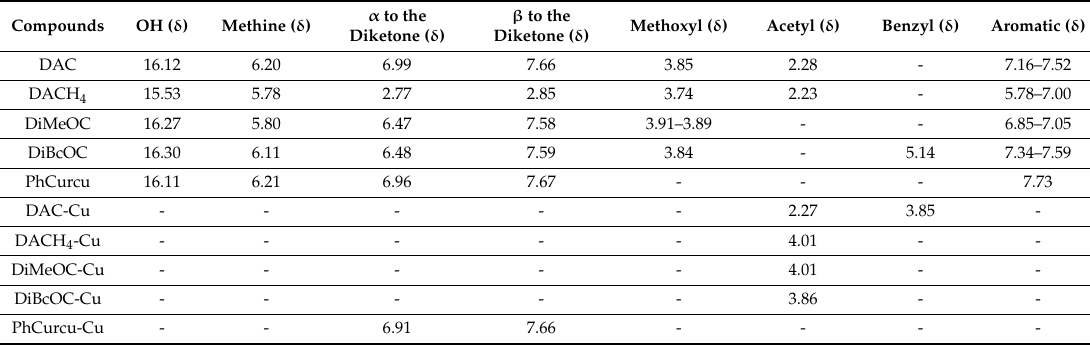
Table 2. 1 H NMR Chemical shifts ( δ ) of compounds 1 – 10